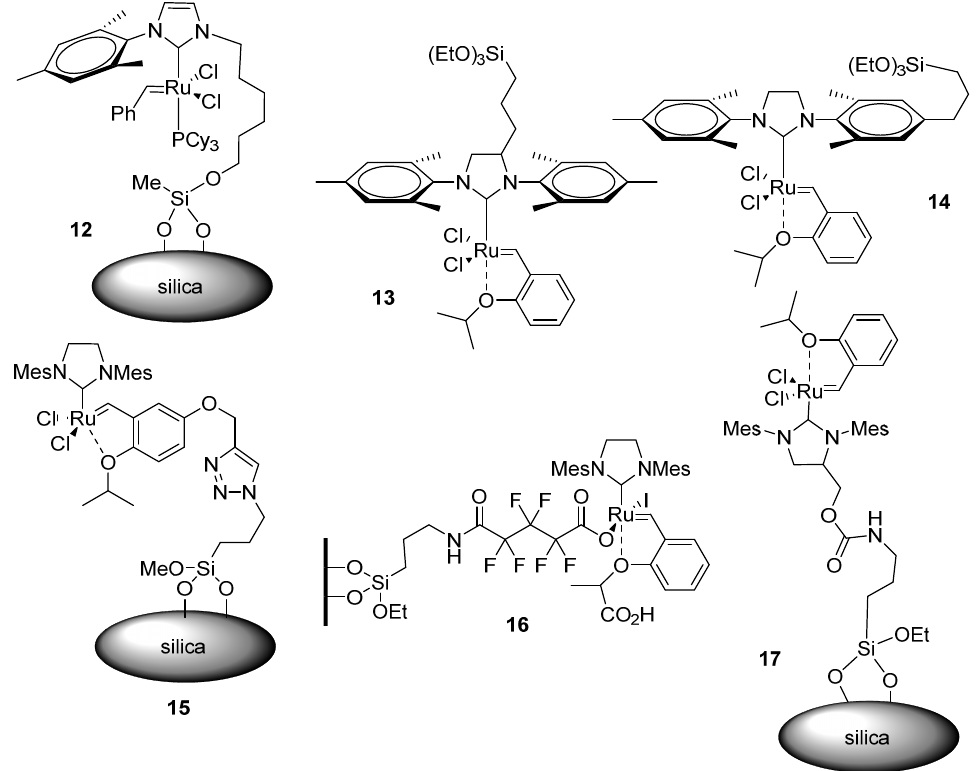
Figure 3. Examples of silica-supported olefin metathesis catalysts 12 – 17 .